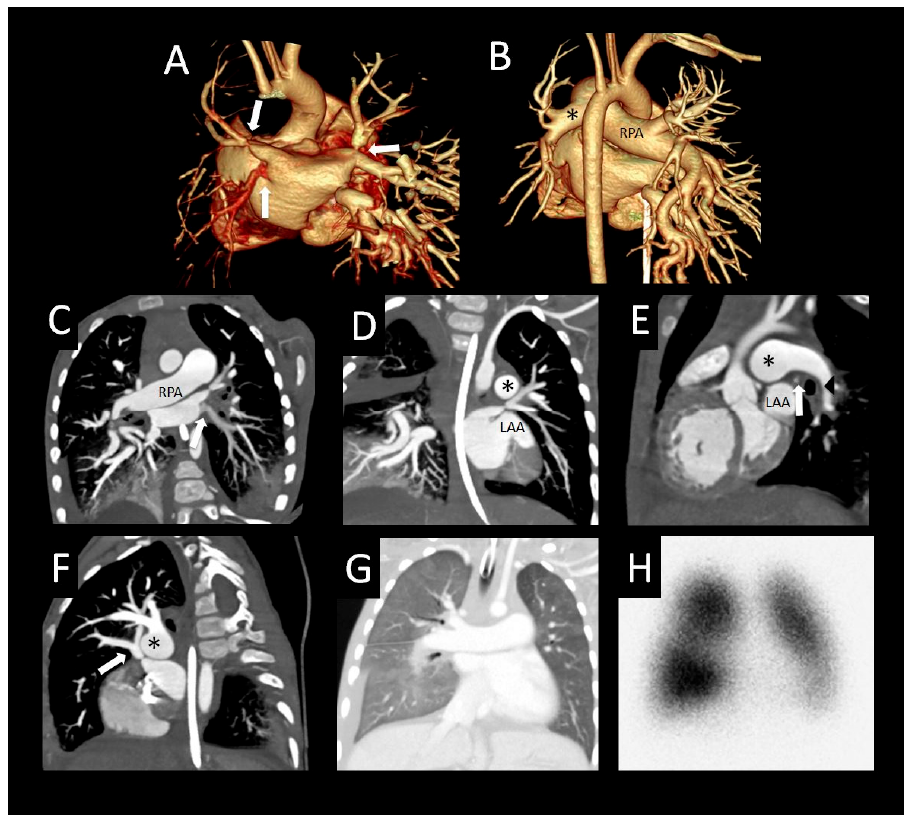
Figure 4. Primary pulmonary vein stenosis. Primary pulmonary vein stenosis diagnosed at 1 year with respiratory distress that was thought to be pneumonia, but failed to improve with antibiotics. Posterior volume rendered CT images show bilateral pulmonary vein stenosis with narrowing of multiple pulmonary veins (arrows), left > right ( A ), dilated right pulmonary artery (RPA), and small distal left pulmonary artery (*) with hypoplastic left hilar branches ( B ). Oblique coronal image ( C ) shows oblique course and decreased enhancement of the left lower pulmonary vein (arrow). Coronal ( D ) and sagittal ( E ) images show severe focal narrowing of the left upper pulmonary vein (arrow) as it courses between the left atrial appendage (LAA), a dilated main/left pulmonary artery confluence (*) and left bronchus (arrowhead). The right upper pulmonary vein also has severe focal narrowing as it courses by the dilated right pulmonary artery (RPA) (*) (( F ) sagittal oblique image). Coronal lung image ( G ) shows right > left pulmonary edema, a small right pleural effusion, and left lung hypoplasia. Perfusion scintigraphy anterior image ( H ) shows 34% left and 66% right lung perfusion with decreased relative perfusion of the left lower